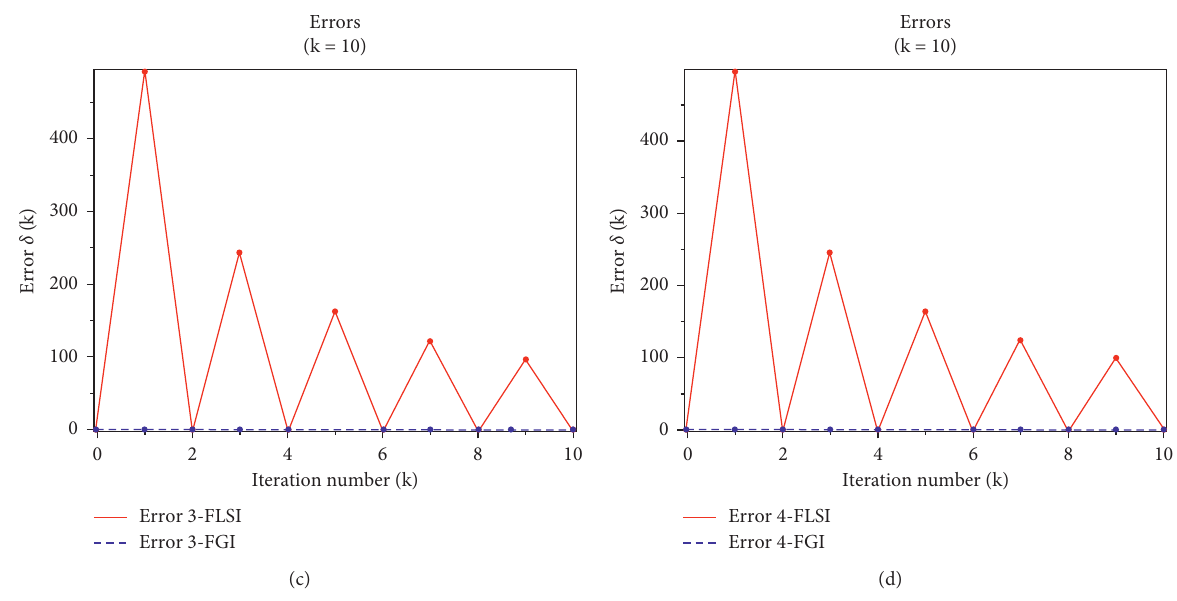
Figure 3: Comparison between relative δ l ( k ) of FGI and FLSI for the first ten iterations for Example